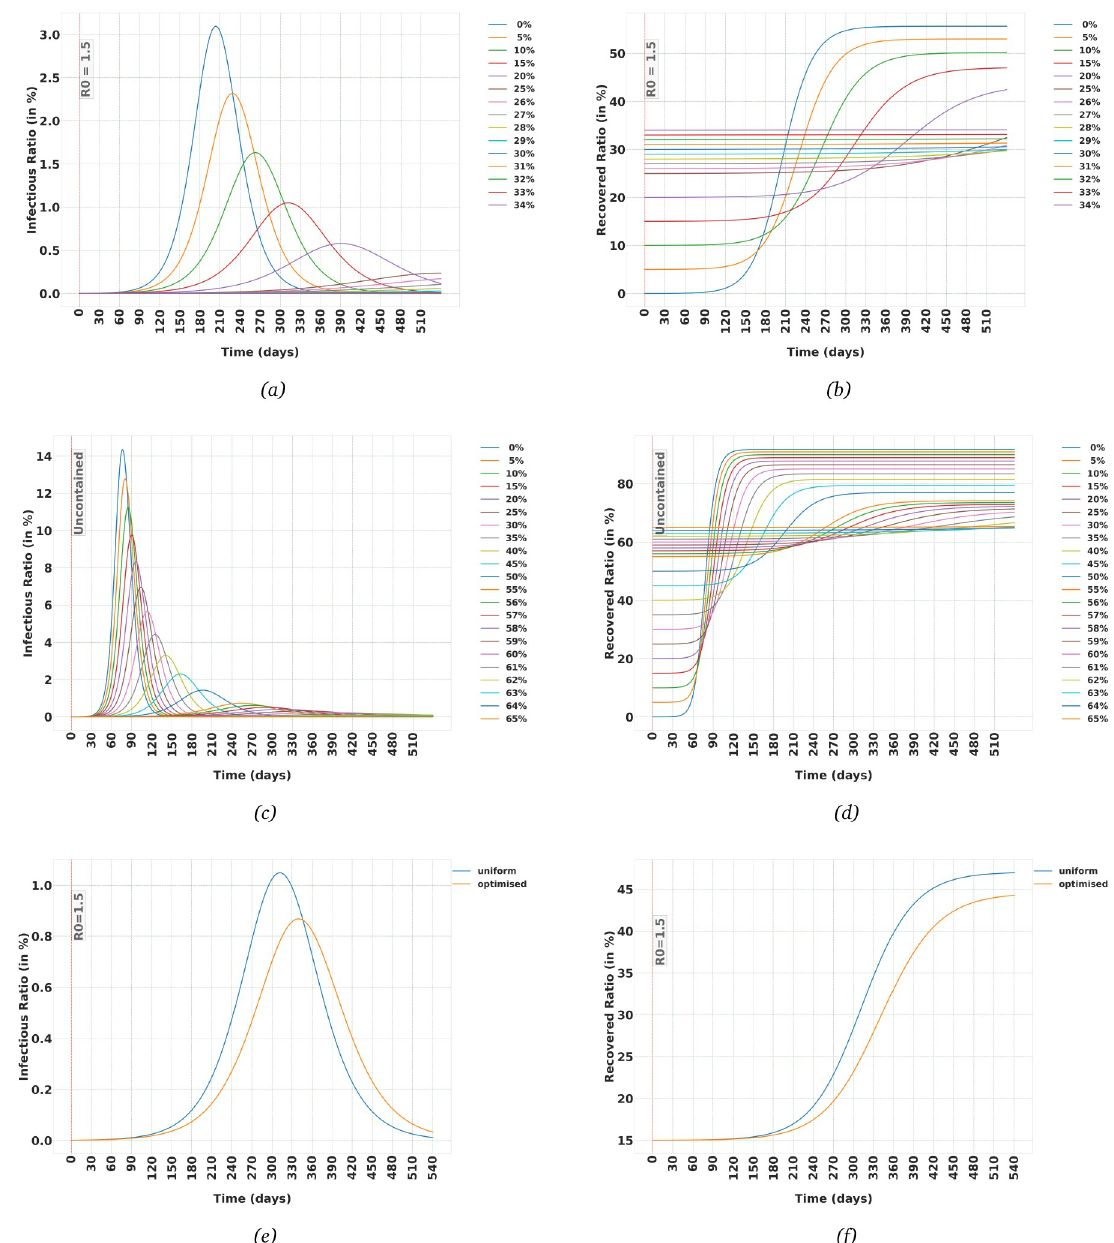
Fig 4. (a,b) The effect of vaccinating different ratios of the population of Germany on the evolution of the Infectious and Recovered trajectories. Each line corresponds with a different initial ratio of Recovered in the population. It is assumed population is under a containment policy that imposes R 0 = 1.5, (c,d) Same as (a) and (b), but it is assumed the population is uncontained, (e,f) Difference between uniform vaccinations and optimally distributed vaccination in Infectious and Recovered ratio when we have enough vaccines to vaccinate only 15% of the population. Optimal distribution of the vaccines allows us to end up with around 2.7% reduction in the total number of infected.